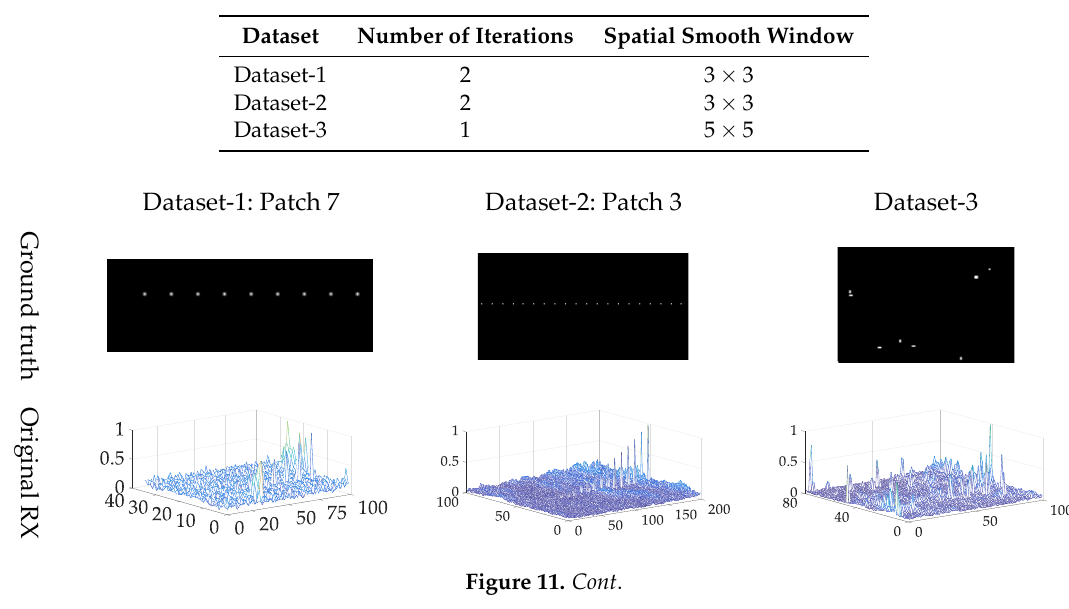
Table 4. Iterations and window size.